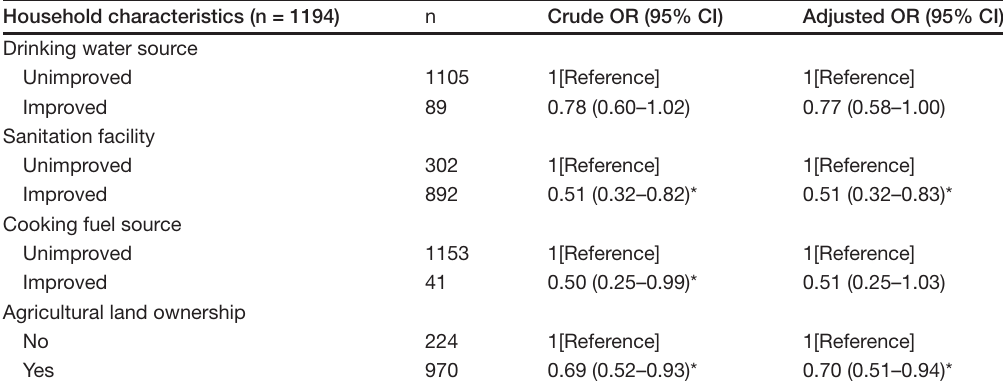
Table 3. Logistic regression models for household characteristics on stunting (HAZ <−2) standardised coefficients and CIs. Household characteristics (n =